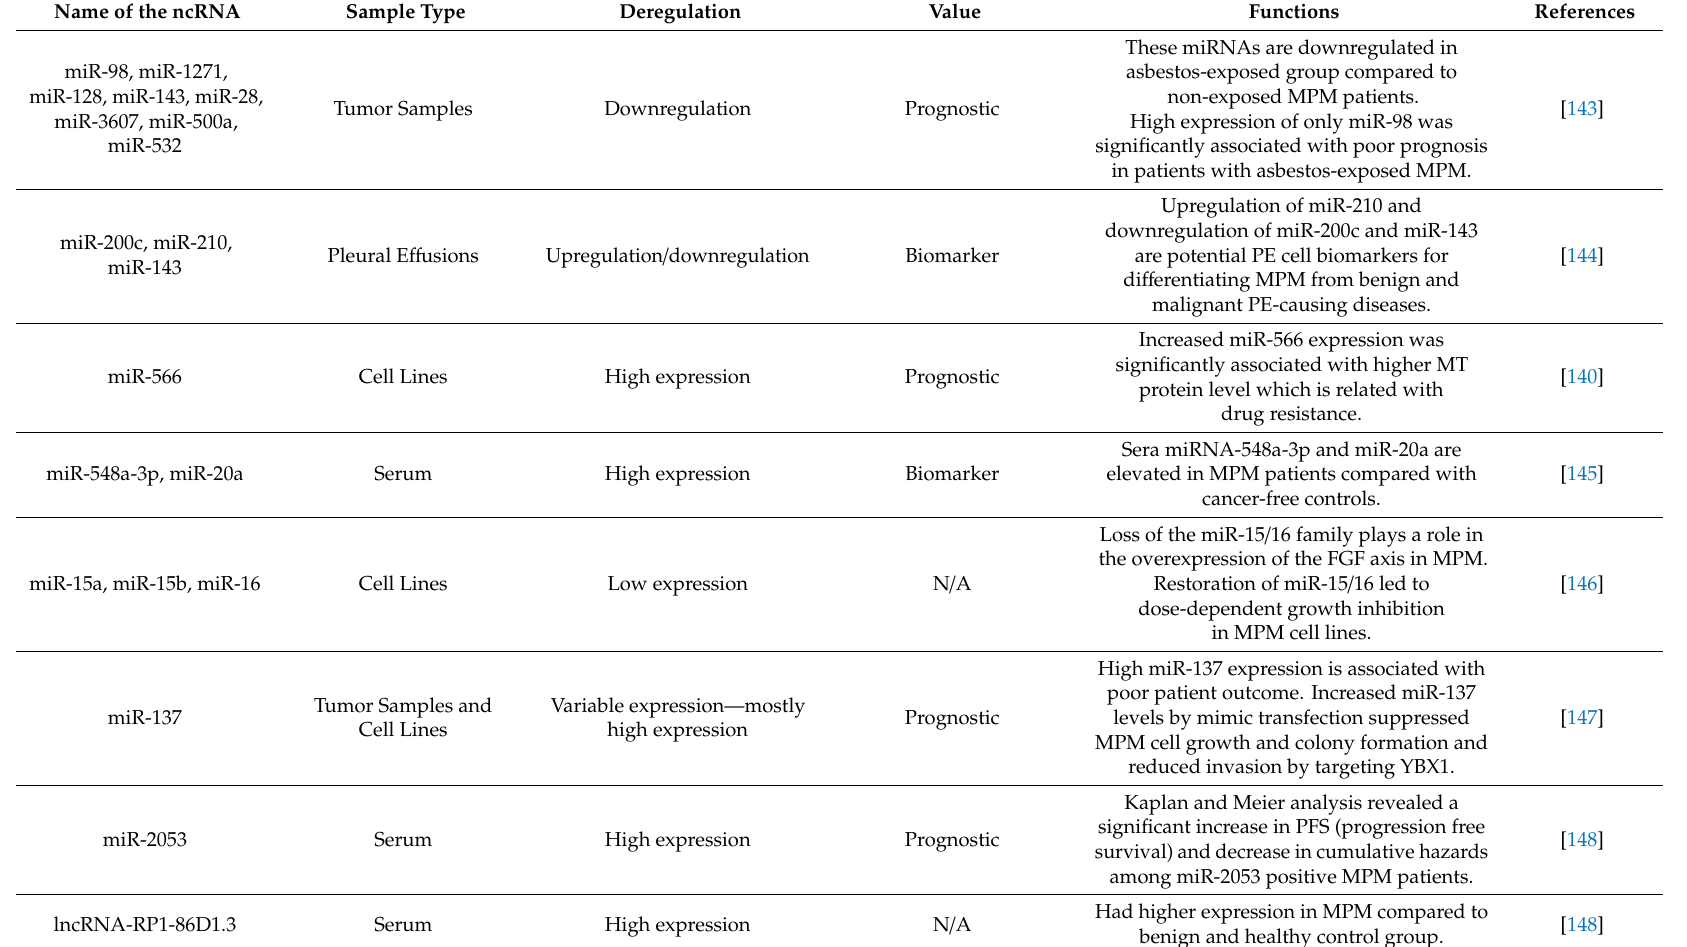
Table 2. Dysregulated ncRNAs with biological activity in MPM. N / A: data not